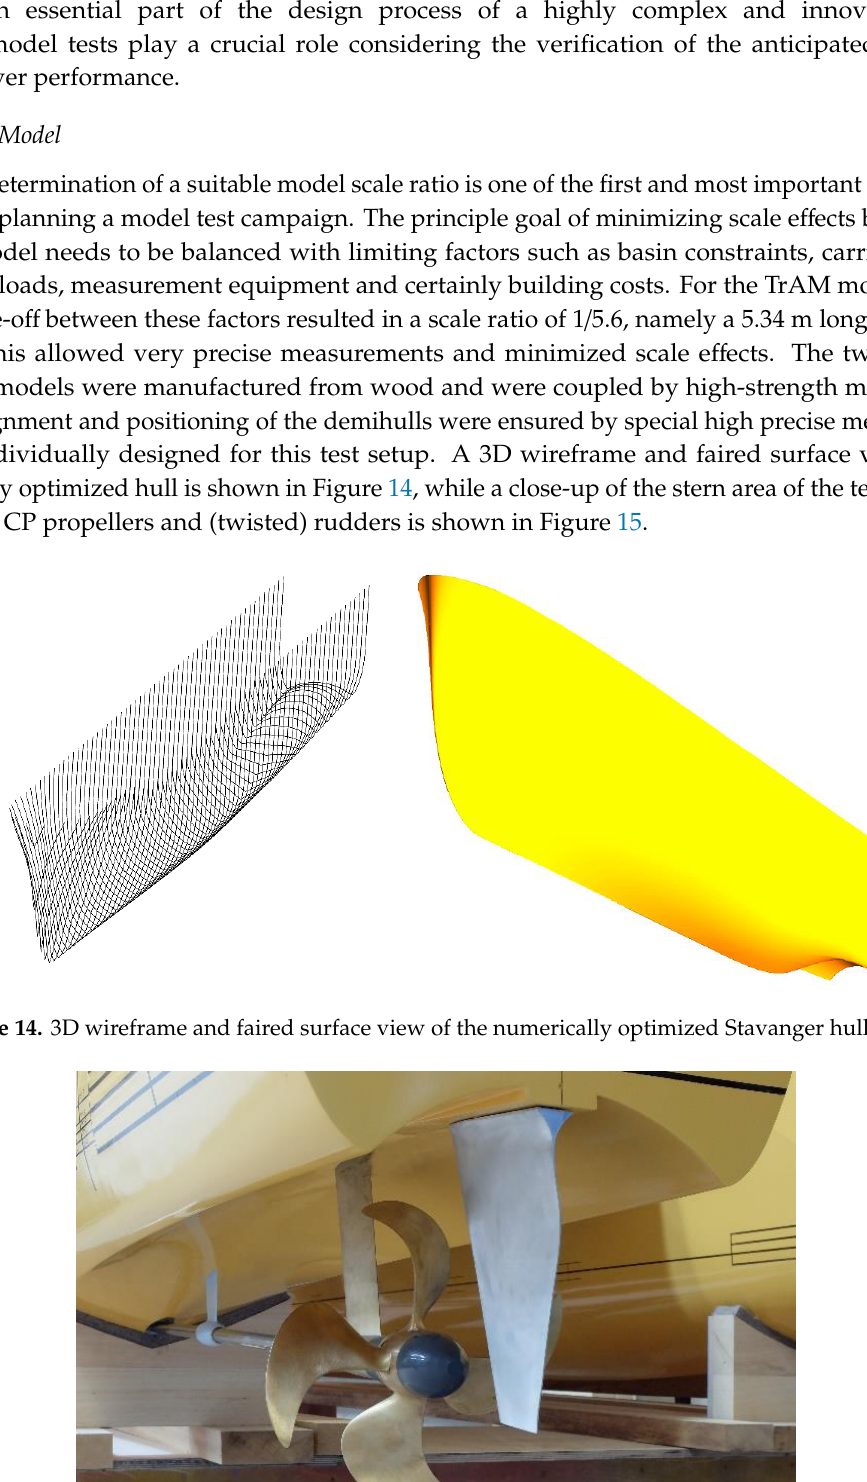
Figure 13. Streamlines through propeller discs and propeller body force distribution at 23 knots.